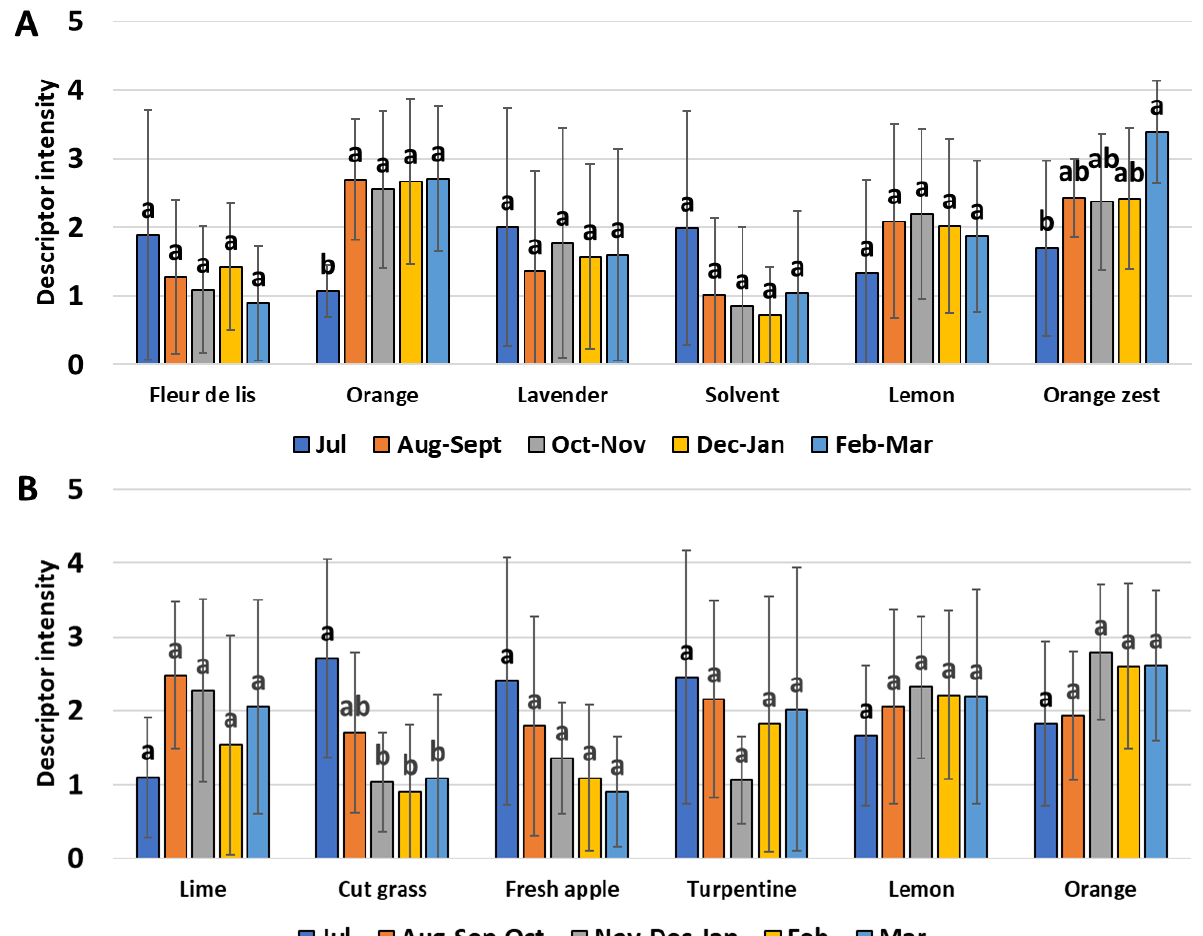
Figure 6. Bar plots representing the evolution of the five sensory descriptors of “Cara Cara Navel” ( A ) and “Madame Vinous” ( B ) sweet oranges during fruit development. The vertical bar represents the standard deviation , and the letter represents the statistical group according to Tukey’s test.